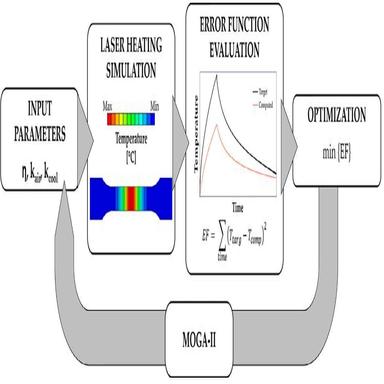
Schematic description of the optimization workflow.